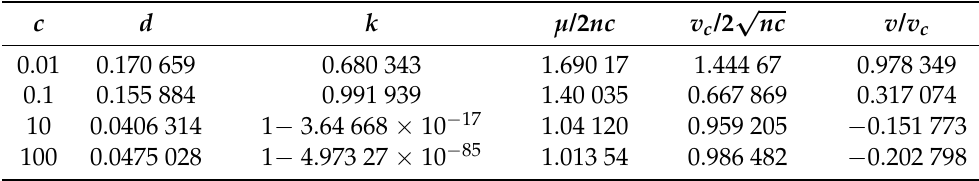
Table 2. Parameters of the density profiles of the elliptic dark-soliton solutions in Figure